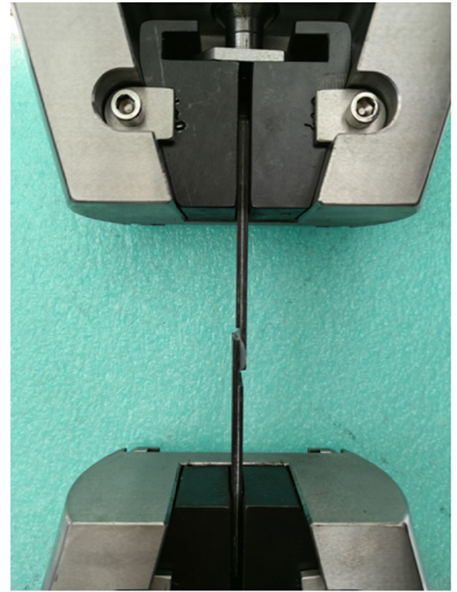
Figure 4. Tensile shear test of single-lap specimen.